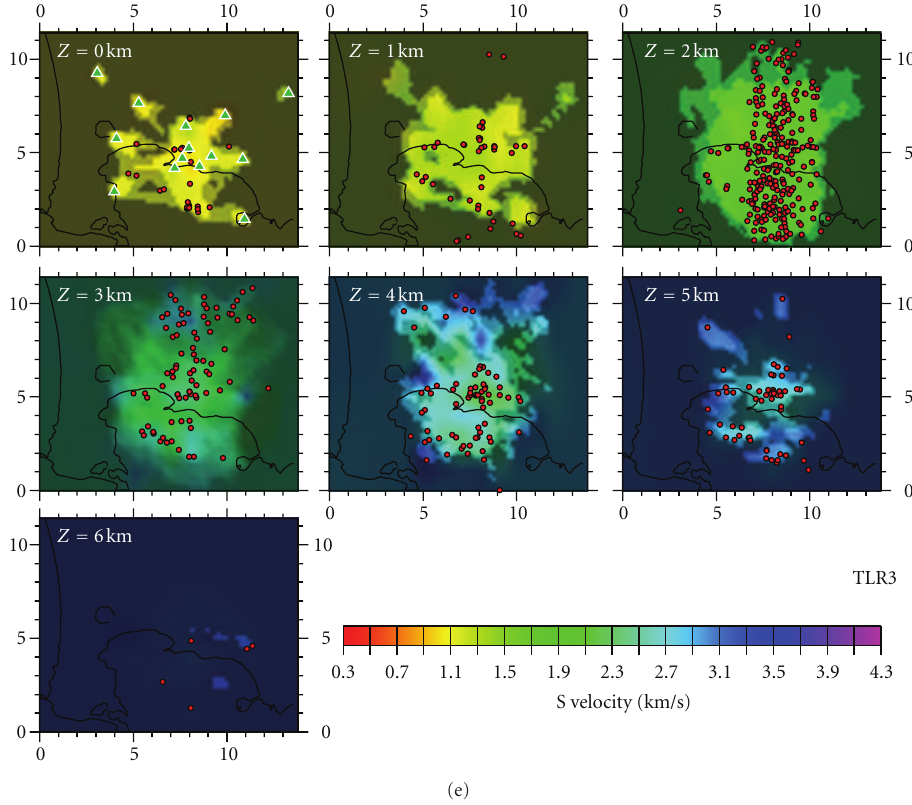
Figure 19: Same as Figure 17, in this case for V S